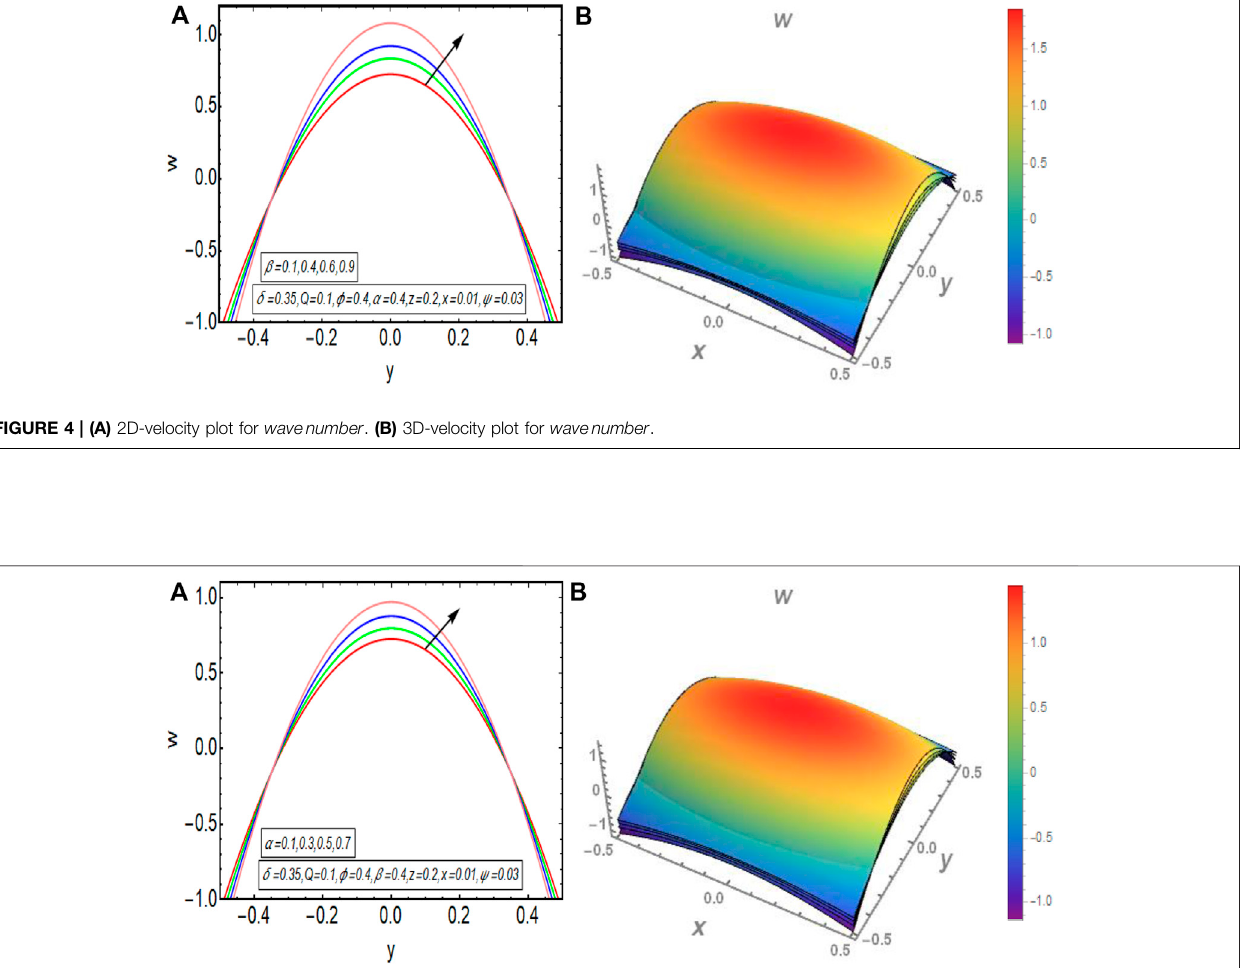
FIGURE 5 | (A) 2D-velocity plot for ellipticalmotioneccentricity . (B) 3D-velocity plot for ellipticalmotioneccentricity .